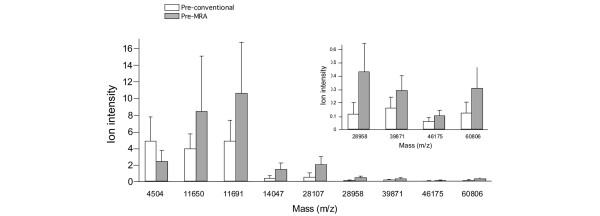
Differences between mass spectra of sera before and after MRA treatment for SJIA. Sera were taken before and after treatment with MRA from patients for whom conventional therapy had failed. The high significance of these differences suggests a profile predictive of response to conventional therapy. The values represent mean intensities. The P values of these univariate comparisons are given in Table 2. Error bars represent standard deviations. MRA, humanized anti-IL-6 receptor monoclonal antibody; SJIA, systemic-onset juvenile idiopathic arthritis.